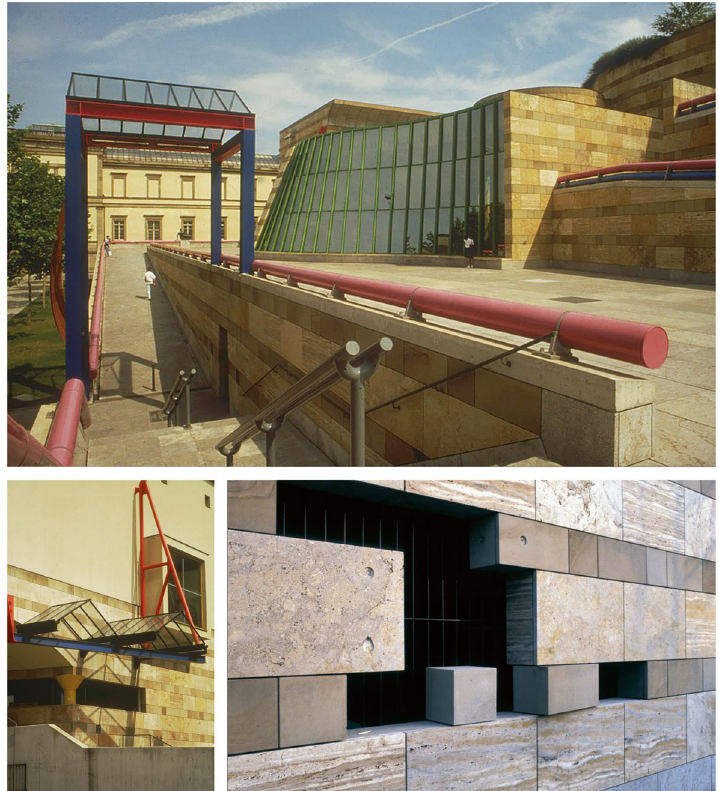
Fig. 5 Neue Staatsgalerie, Stuttgart, Germany, 1984. James Stirling & Michael Wilford architects. (Source: Columbia University Avery